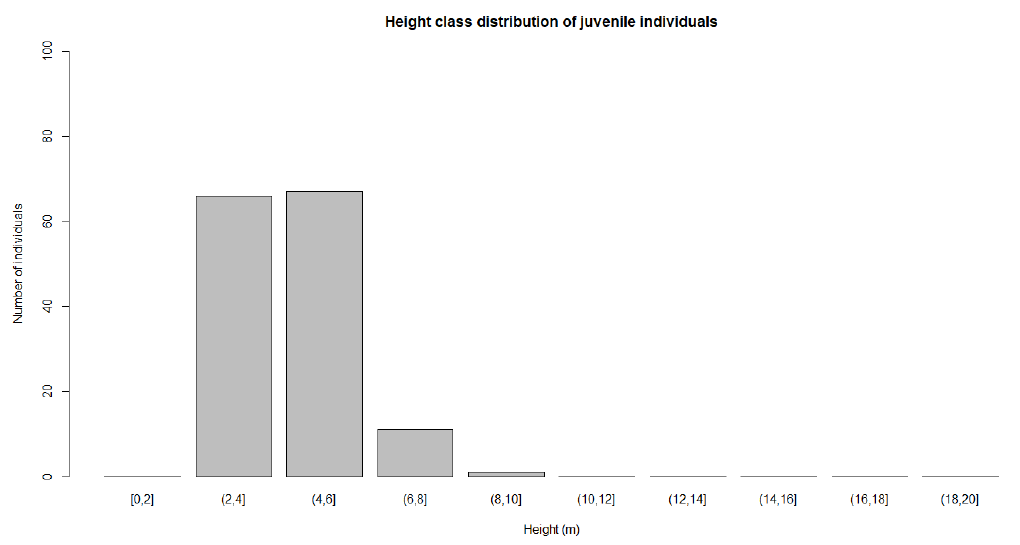
Figure 10. Height class distribution of juvenile individuals.